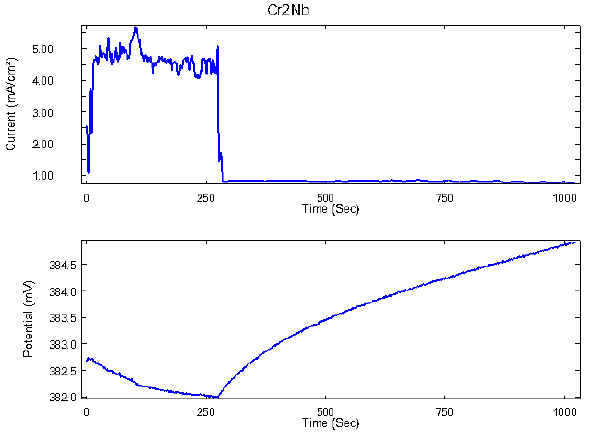
Figure 9. EN behavior at 8 h of milling.